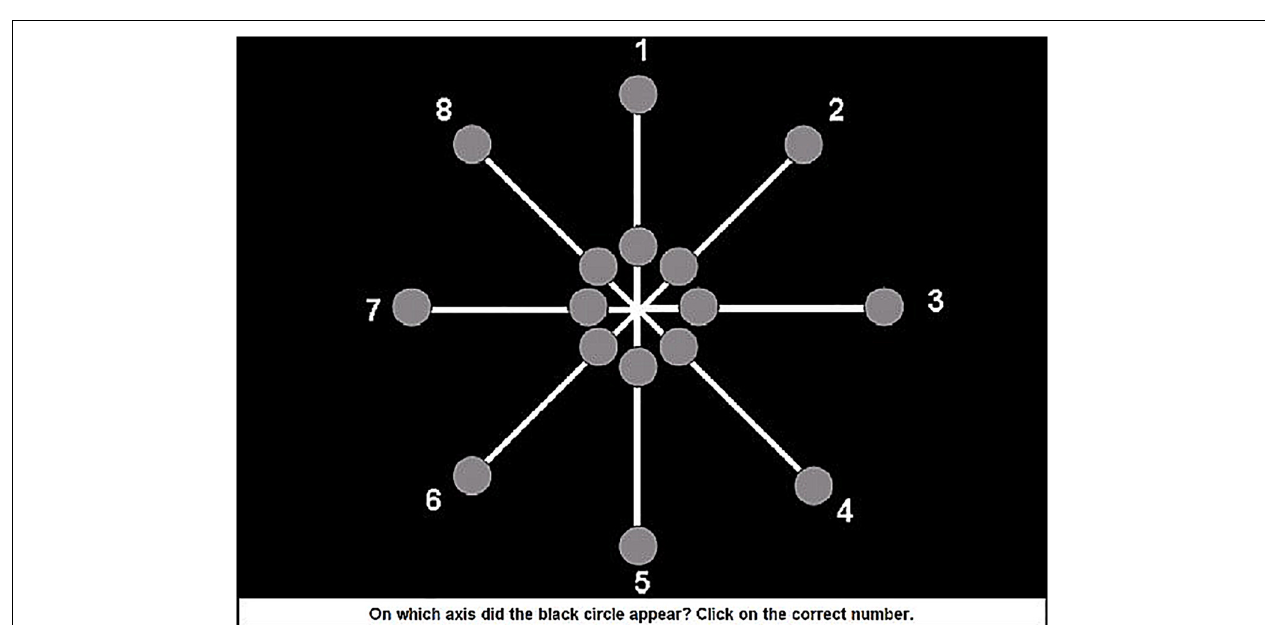
FIGURE 2 | Response screen axe of the target stimuli. Note: based on Van Beveren et al.